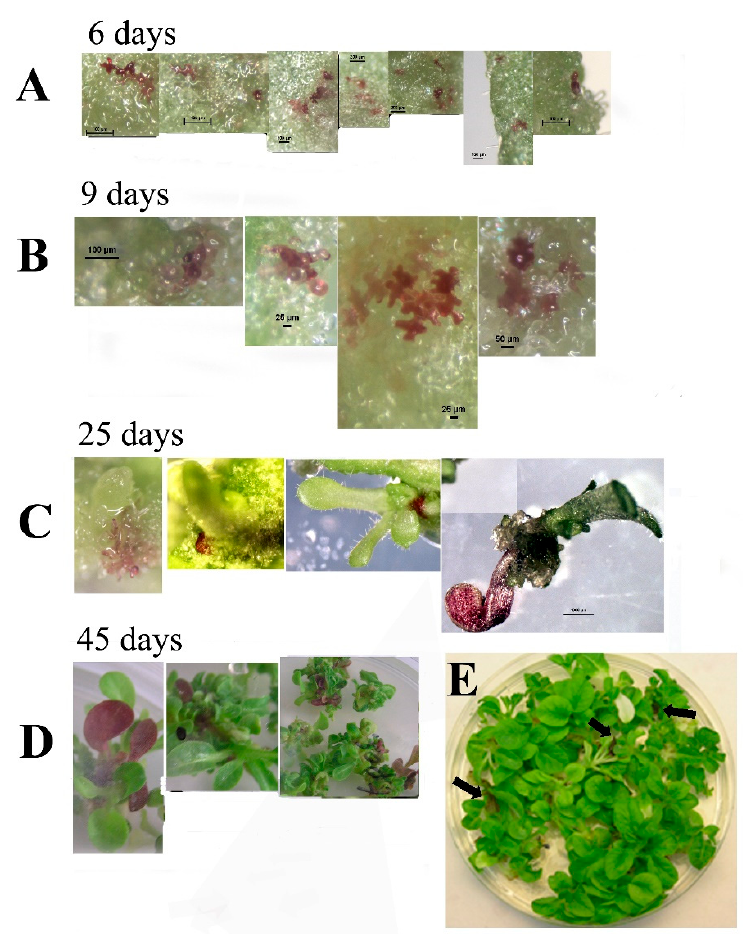
Figure 4. Bright light pictures of leaf segments transformed with the 35S::ScANT1 construct, taken at various time points following transformation and explant growth on regeneration medium without Kanamycin selection. ( A ) leaf segments showing pigmented cells 6 days after transformation. ( B ) leaf segments showing pigmented cells 9 days after transformation. ( C ) tissue showing pigmented section 25 days after transformation. ( D , E ) plants showing pigmented leave 45 days after transformation. Arrows point to the colored leaves in the plate.